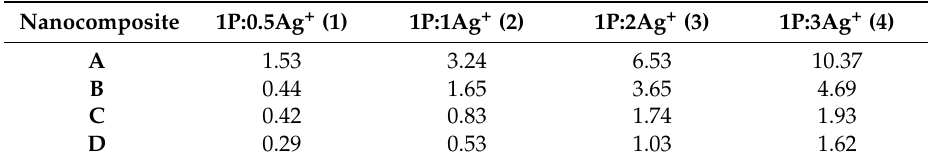
Table 3. Silver loading (%) of the different nanocomposites.